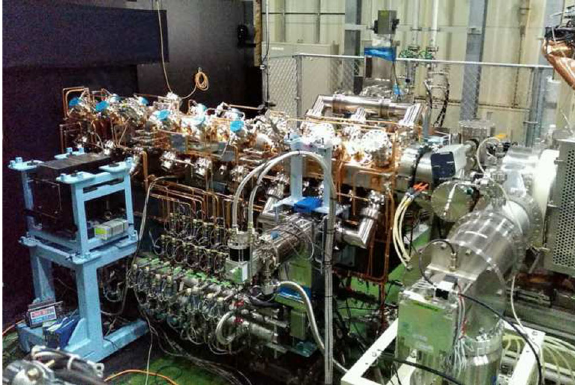
FIG. 7. Photograph of epRFQ installed in the test stand.